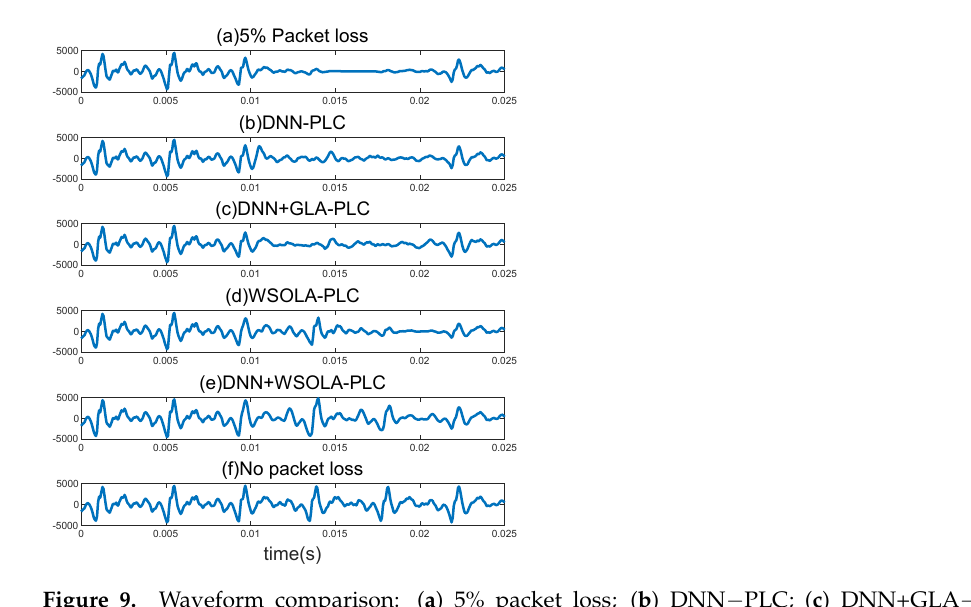
Figure 9. Waveform comparison: ( a ) 5% packet loss; ( b ) DNN − PLC; ( c ) DNN+GLA − PLC; ( d ) WSOLA − PLC; ( e ) DNN+WSOLA − PLC; ( f ) no packet loss.